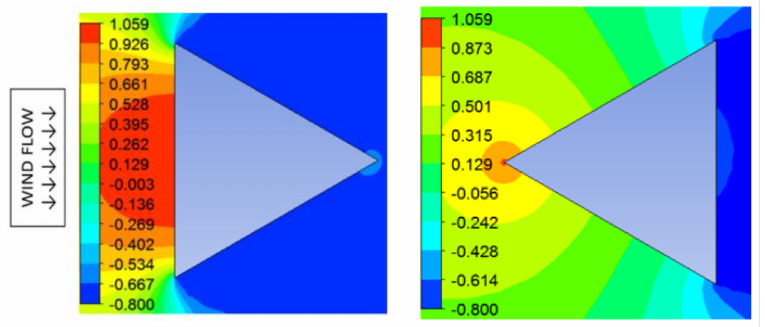
Figure 12. Calculated wind pressure coefficient: ( a ) Wind direction 1; ( b ) Wind direction